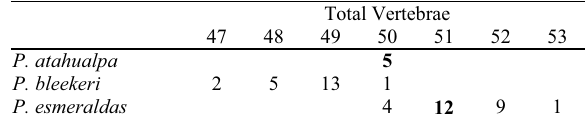
Table 29. Number of specimens of species of Paracetopsis with cited number of total vertebrae. Bold indicates value for holotype when